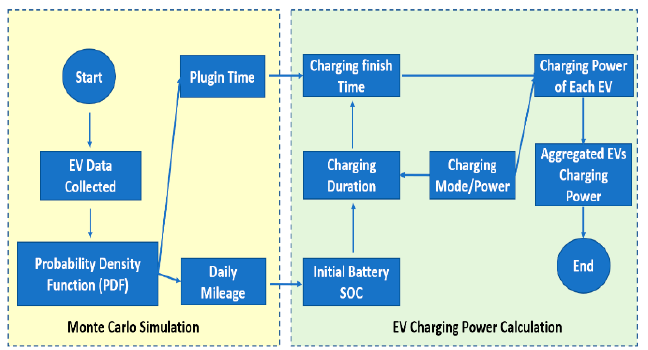
Figure 4. EV charging calculation diagram.